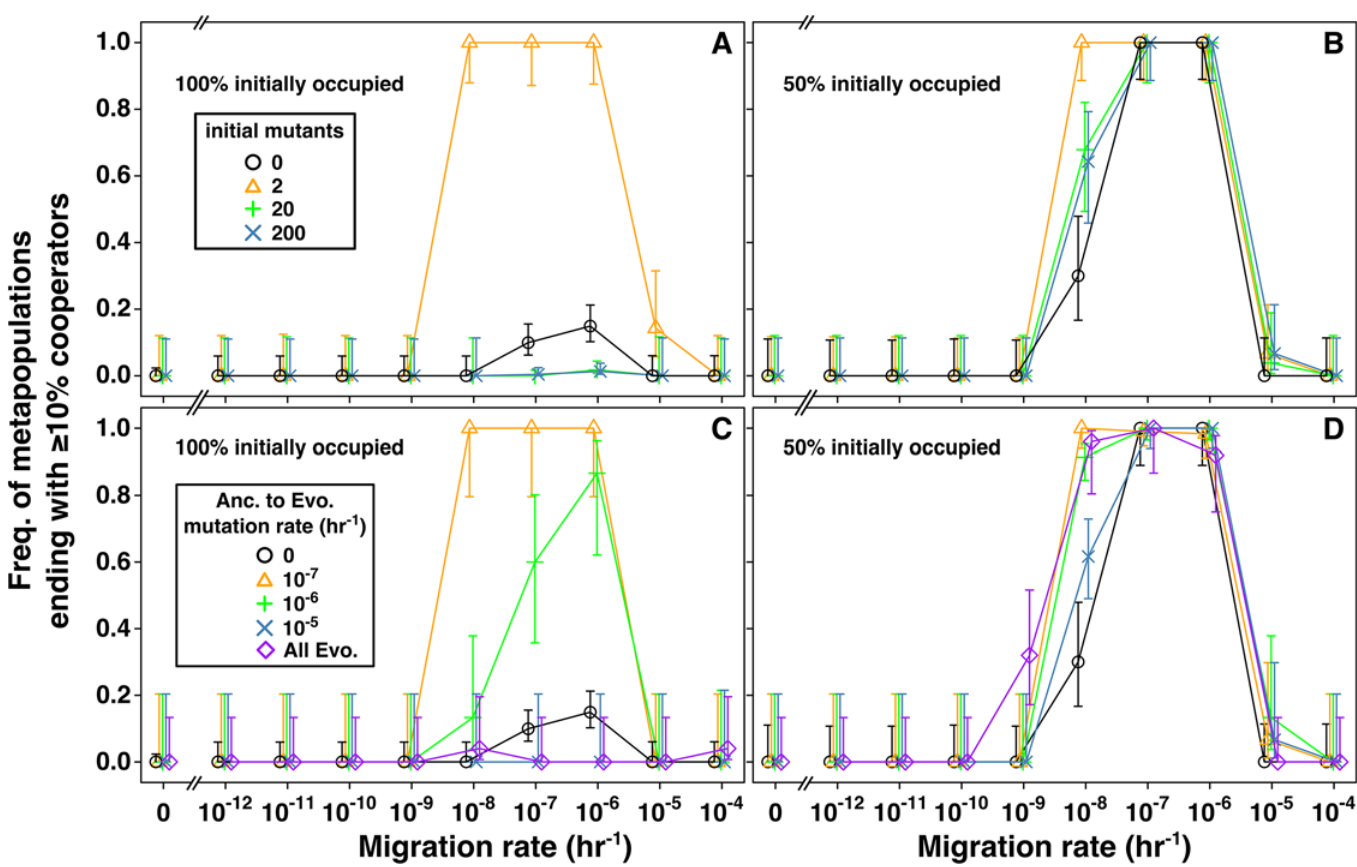
Fig 7. High-fitness mutants can improve the survival of cooperation. A-B ) Non-empty locations in each simulation were initialized with a total of 10 5 cells at a cooperator to defector ratio of 1:1. Each of these populations were seeded with a total of 0 (black circle), 2 (orange triangle), 20 (green plus), or 200 (blue x) initial mutants, also at a C * to D * ratio of 1:1. A ) 100% of locations initially occupied. B ) 50% of locations initially occupied. C-D ) Instead of seeding the initial mutants, initial C and D populations were given an ancestor to evolved mutation rate u * of 0 (black circle), 10 − 7 (orange triangle), 10 − 6 (green plus), or 10 − 5 (blue x) hr -1 . At an extremely high mutation rate, cooperator survival should approximate that in C * / D * metapopulations, plotted here for comparison (purple diamond). Trends in C and D are qualitatively similar to those in A and B . Data is slightly shifted about the x-axis to aid visualization of overlapping